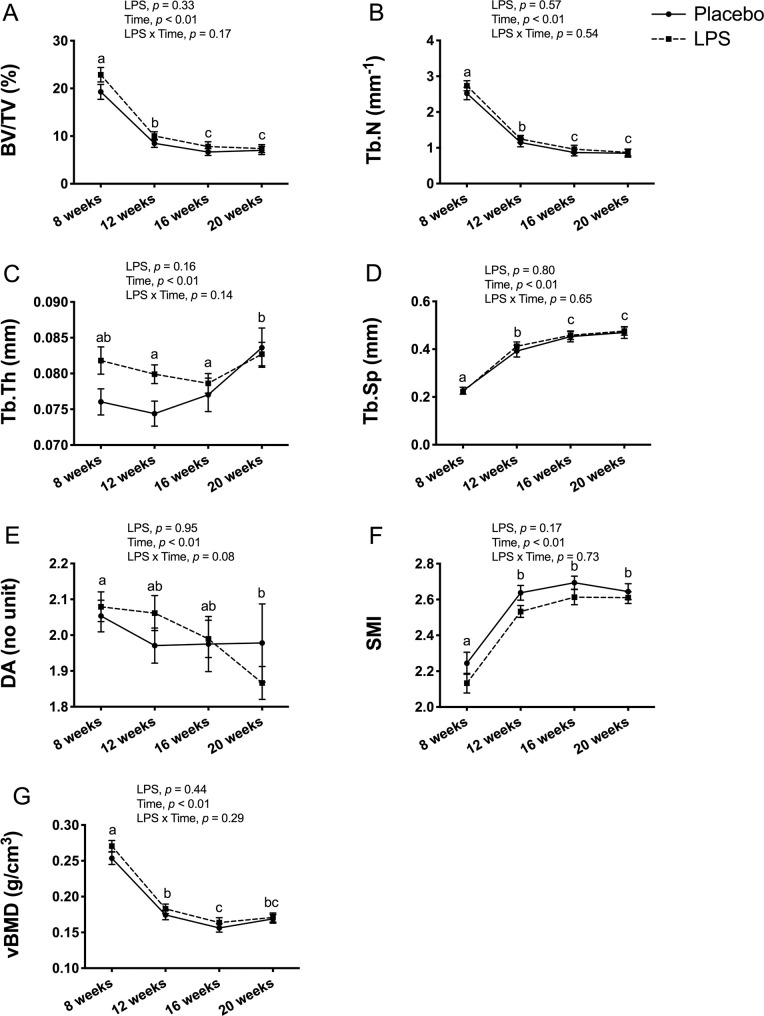
Male trabecular bone structure and volumetric bone mineral density (vBMD) at proximal tibia metaphysis.Trabecular bone structure and vBMD were unaltered with 12-weeks of lipopolysaccharide (LPS) treatment between the placebo (n = 12) and LPS group (n = 30). (A) Bone volume fraction (BV/TV) (B) Trabecular number (Tb.N) (C) Trabecular thickness (Tb.Th) (D) Trabecular separation (Tb.Sp) (E) Degree of anisotropy (DA) (F) Structural model index (SMI) (G) Trabecular vBMD (g/cm3). Data represented as mean±SEM. Significant differences between timepoints (main effect for time) are denoted with lowercase letters.